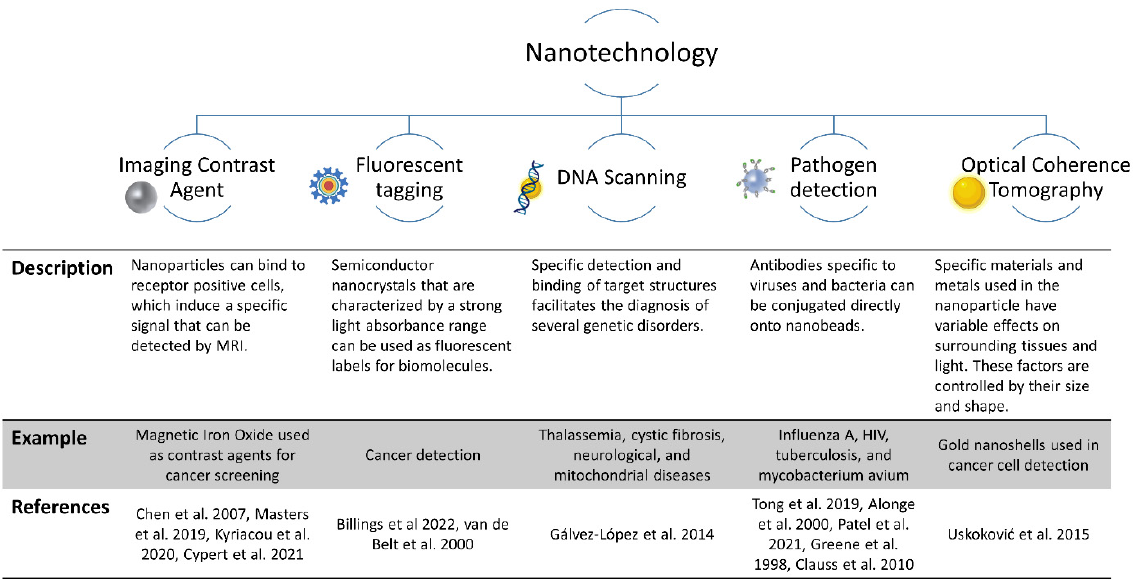
Figure 4. Main uses of nanotechnology in medicine.